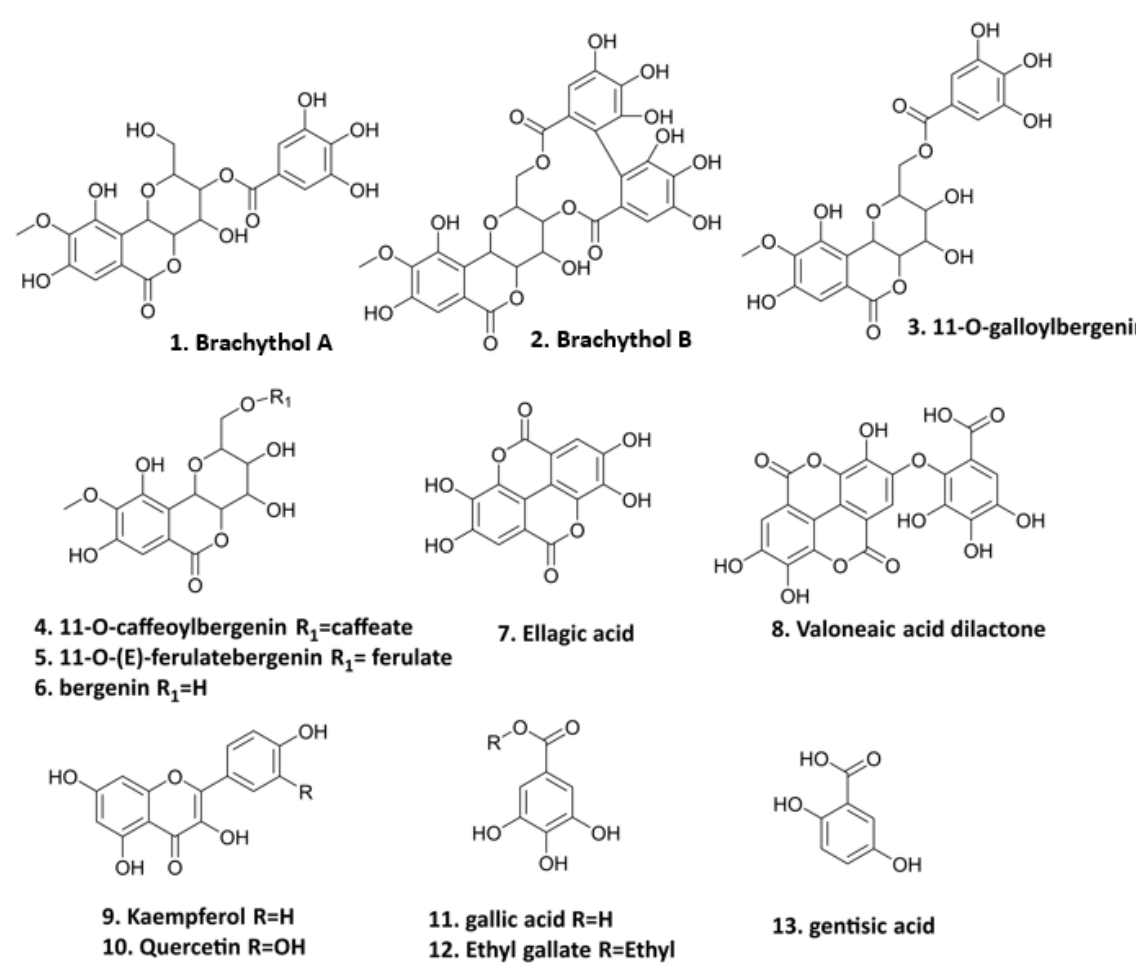
Figure 1. Polyphenolic compounds from PE ( 1 . brachythol A; 2 . brachythol B; 3 . 11-O- galloylbergenin; 4 . 11-O-caffeoylbergenin; 5 . 11-O-(E)-ferulate; 6 . bergenin; 7 . ellagic acid; 8 . valoneaic acid dilactone; 9 . kaempferol; 10 . quercetin; 11 . gallic acid; 12 . ethyl gallate; 13 . gentisic acid).